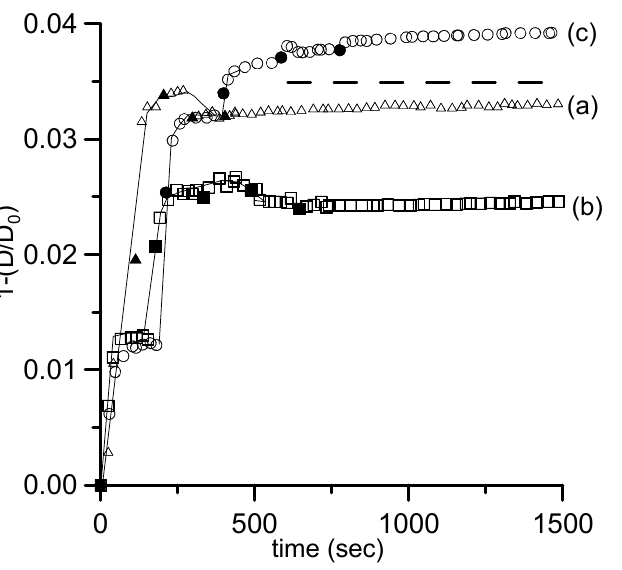
Figure 11. Representation of the polymerization shrinkage 1 − (D/D stepwise lighting mode for composite resins containing 5 mg PMMA/ 0.5 g aerosil. The variable parameter was the duration of the lighting-off period: 1 min ( a ), 2 min ( b ) and 3 min ( c ), respectively. Black symbols correspond to the shrinkage values immediately recorded at the end of each lighting period of 20 s. The horizontal dashed line represents the maximal shrinkage value recorded for the quite continuous lighting of the